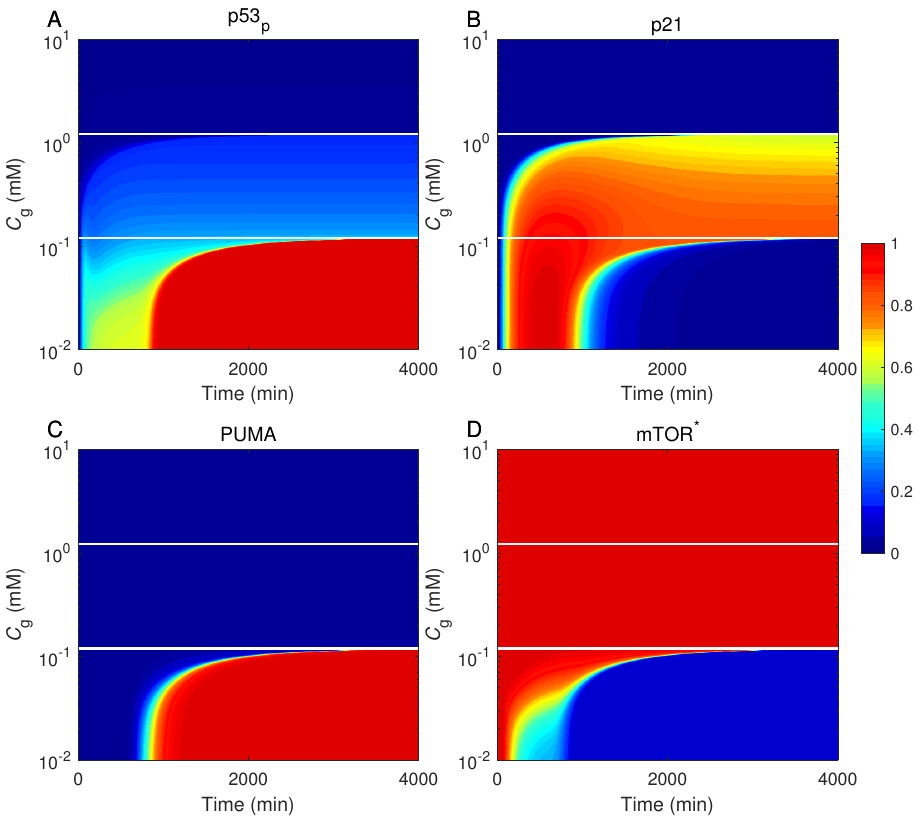
Figure 4. 4-1 Figure 4. Different cellular outcomes after glucose restriction. Displayed are the levels of p53 p ( A ), p21 ( B ), PUMA ( C ), and mTOR* ( D ) as a function of time and glucose level C g . The protein levels are normalized to their respective peak values (see the color scale bar on the right). There exist three kinds of cellular outcomes: proliferation ( C g ≥ 1.2 mM), senescence (0.12 ≤ C g < 1.2 mM), and apoptosis ( C g < 0.12 mM). Two horizontal lines mark C g = 0.12 and 1.2 mM.